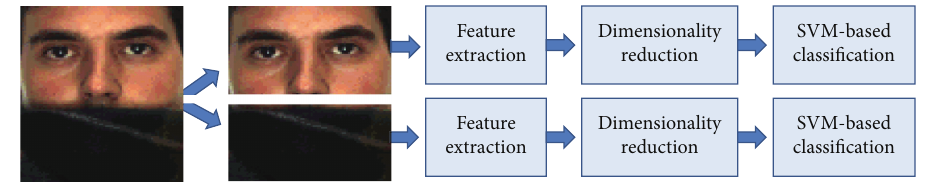
Figure 3: Our occlusion detection